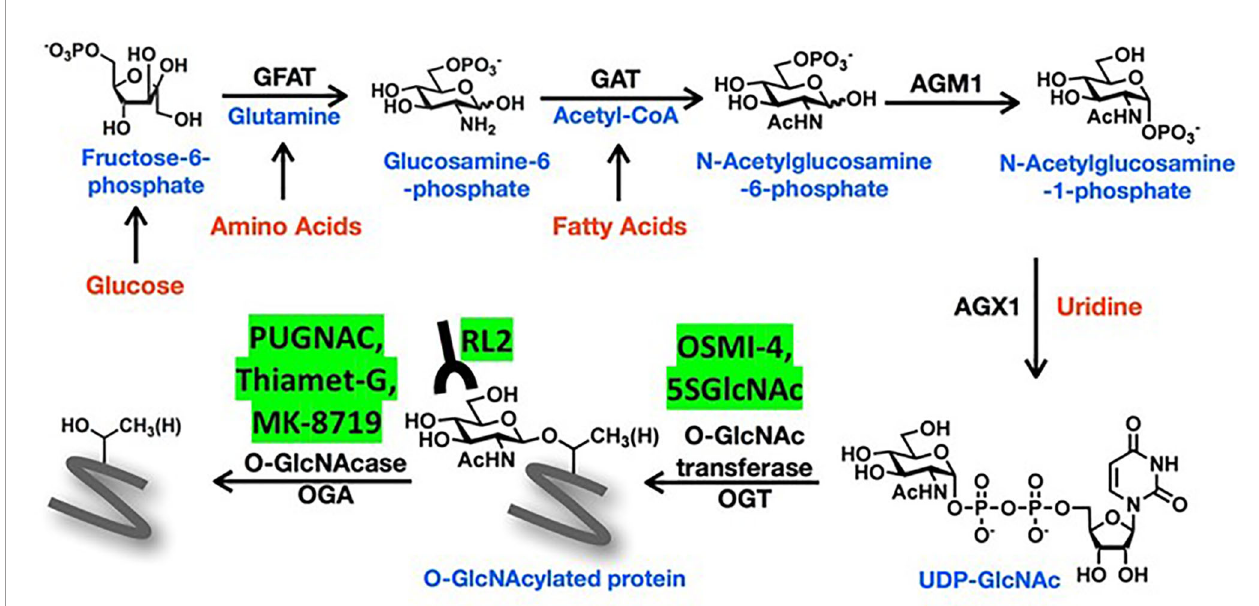
FIGURE 1 | Schema of the hexosamine biosynthetic pathway (HBP). The amino sugar UDP-GlcNAc is generated in the HBP by combining fructose-6-phosphate, glutamine, nucleotides, and acetyl-CoA. More detailed description of the sequential enzyme reactions in the pathway is provided in the text. O-GlcNAc transferase (OGT) uses UDP-GlcNAc to transfer O-GlcNAc moieties onto target proteins that can be recognized by RL2 antibodies and removed by O-GlcNAse (OGA). OGT and OGA inhibitors mentioned in the text are shown in the yellow